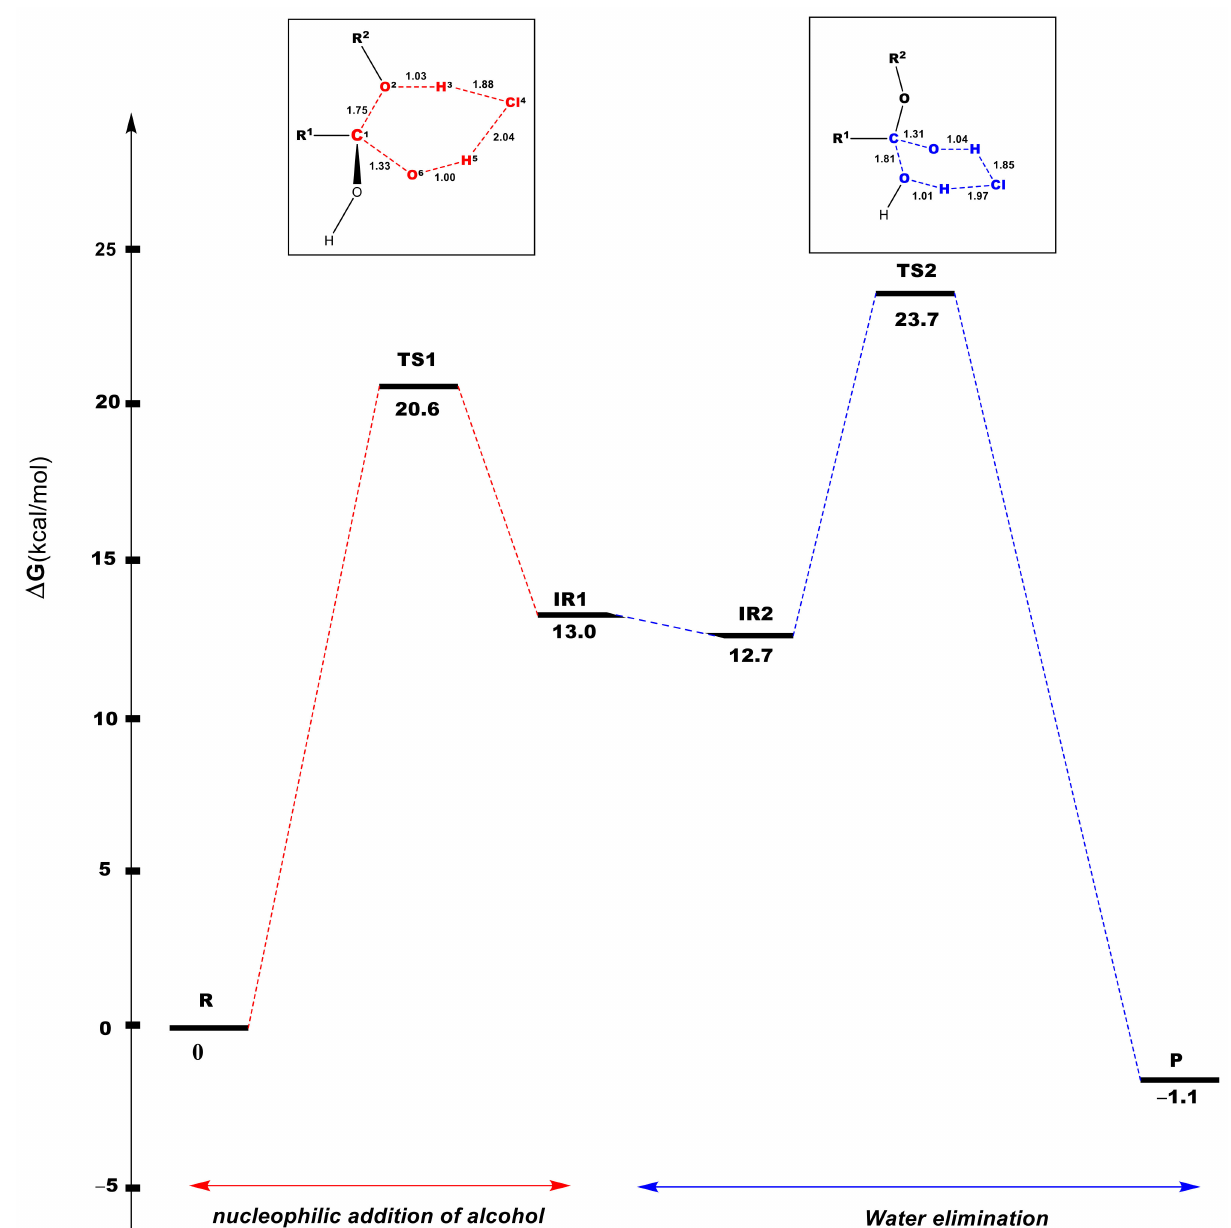
Figure 4. Computed reaction profile for betaine 3 , at the B3LYP/6-31+G(d,p) level. Nevertheless, a question remains: what is the fundamental cause of that reduction in energy cost? A further look at the reaction profiles on Figure 5 suggests the difference starts to manifest itself after the first transition state, that is when going down from TS1 to the reaction intermediates IR1 and IR2. Indeed, IR1- 2 and IR1- 3 appear to be more stabilized with respect to TS1- 2 and TS1- 3 than IR1- 1 is with respect to TS1- 1 , by approximately 7 kcal/mol. This difference remains stable along the rest of the reaction path: overall, it appears that the second step for betaines 2 and 3 is simply shifted downwards by 7